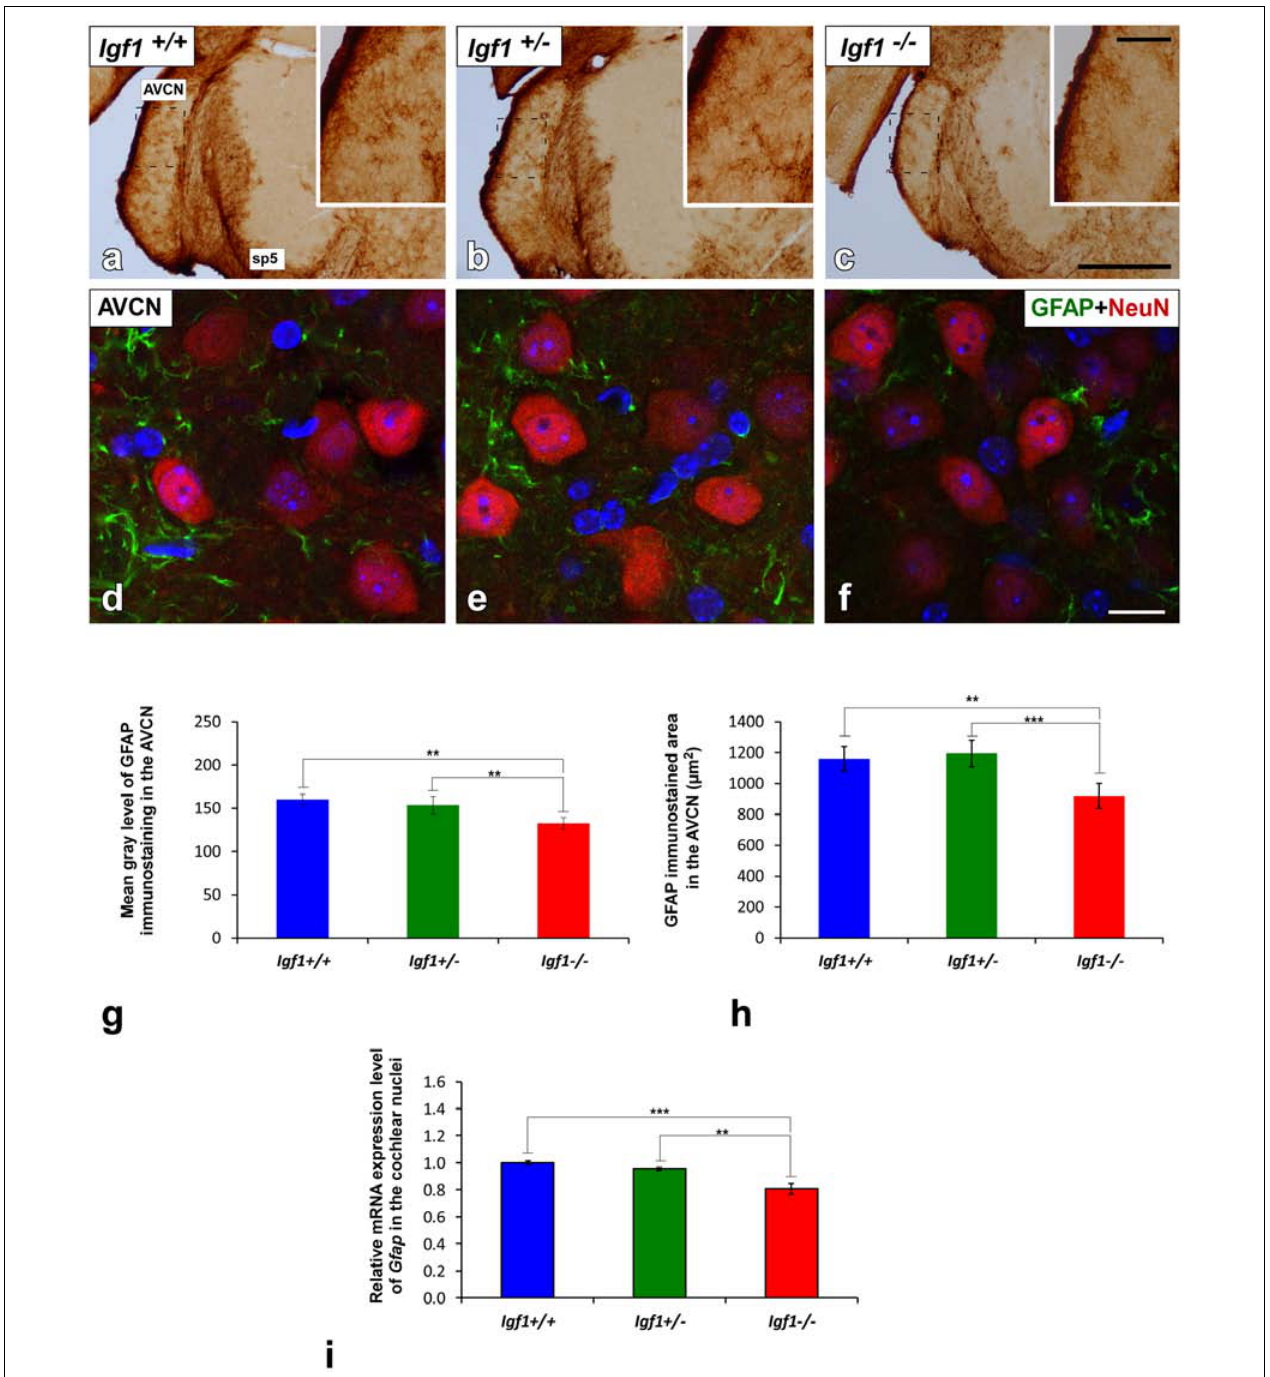
FIGURE 6 | GFAP immunostaining in the AVCN of Igf1 − / − mice. Analysis of GFAP immunostaining in the Igf1 − / − mice showed that there were fewer astrocytes and they were less intensely stained (C,F) when compared to Igf1 + / + (A,D) and Igf1 + / − mice (B,E) . Z-stack confocal microscopy images of GFAP and NeuN double-labeling are shown for all genotypes (D–F) . The apparent decrease in GFAP immunostaining in the Igf1 − / − mouse was corroborated by quantifying the mean gray levels (G) and the stained areas (H) . The qualitative and quantitative data were confirmed when RT-qPCR data showed decreased Gfap expression in the Igf1 − / − mouse cochlear nuclei (I) . The error bars indicate the standard deviations of the mean. Statistically significant differences among the animal groups were evaluated by one-factor ANOVA ( ∗∗ p < 0.01, ∗∗∗ p < 0.001). Cell nuclei are stained with DAPI (blue). The square boxes in a-c indicate the location of the higher magnification images shown in ( A–C ; insets). Abbreviations: AVCN, anteroventral cochlear nucleus; GFAP, glial fibrillary acidic protein; NeuN, neuronal marker; sp5, spinal trigeminal nucleus. Scale bars: 500 µ m in ( C ; it also applies to A,B ); 100 µ m in the inset in ( C ; it also applies to insets in A,B ) and 20 µ m in ( F ; it also applies to D,E